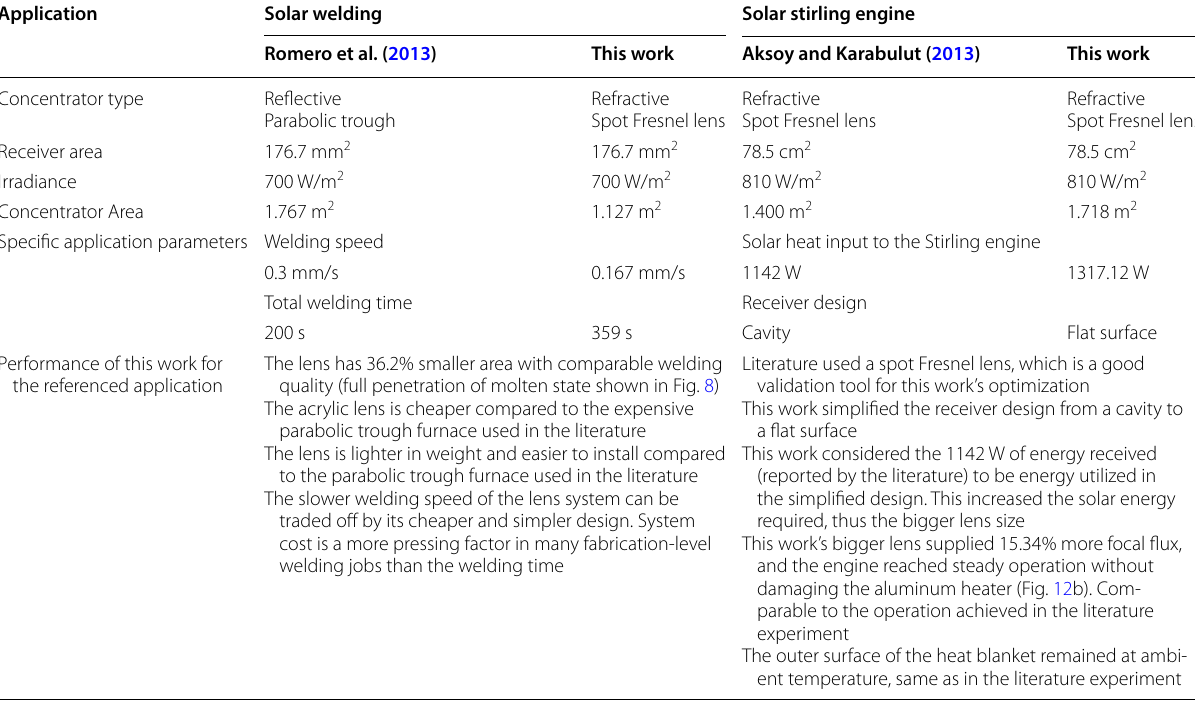
Table 5 Comparative summary of this work for the two literature applications